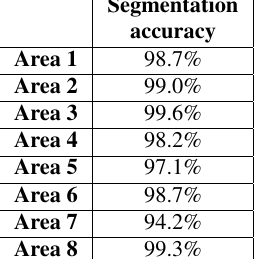
Table 9. Matching of the polygons obtained after regularisation with the ones from the manual delineation.